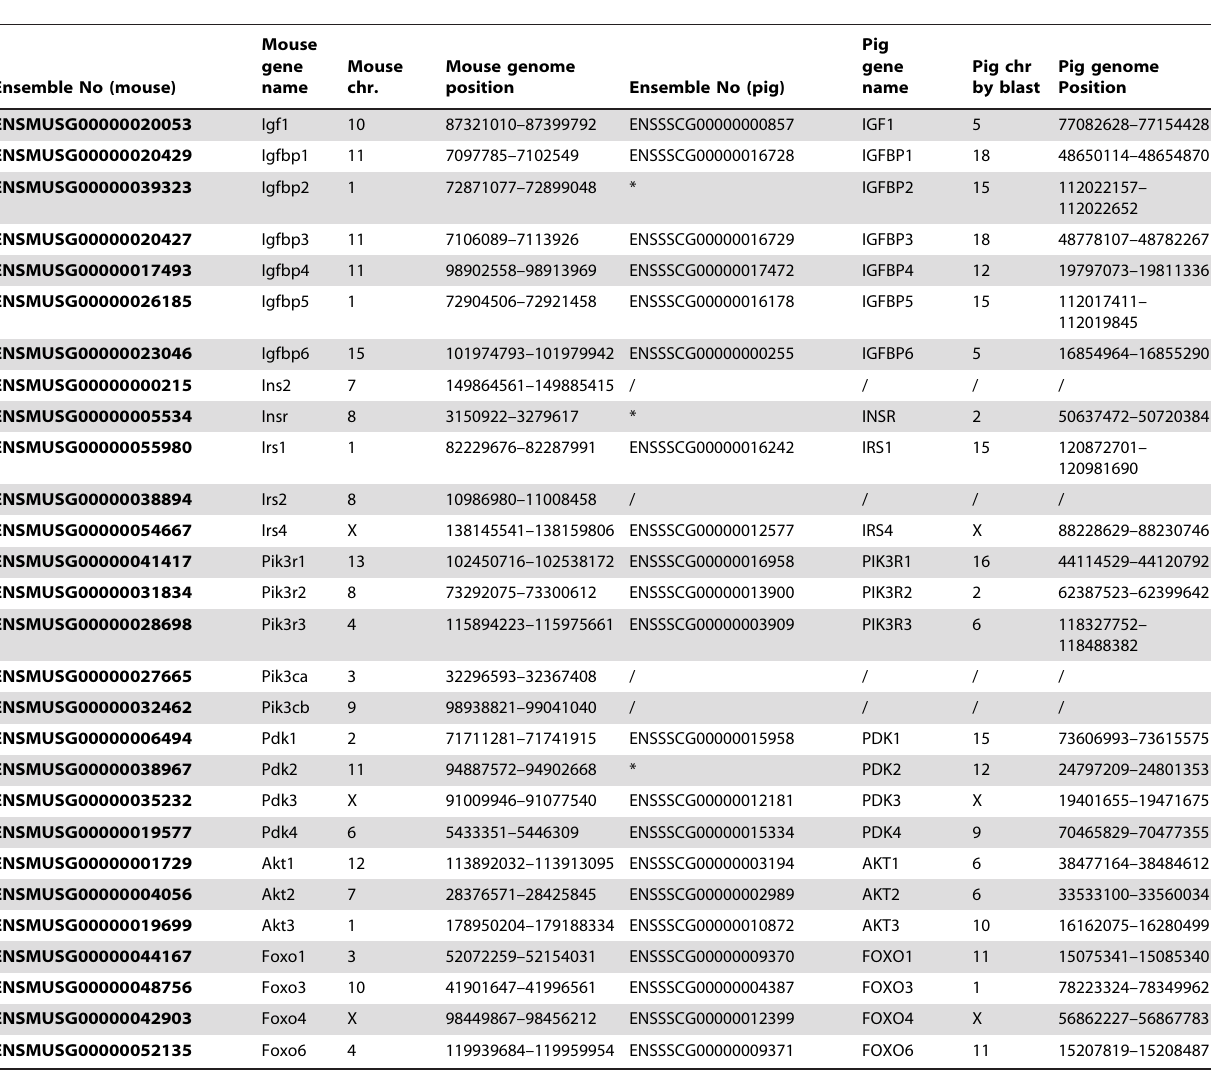
Table 1. The comparison of orthologs members between pig and murine IGF1/FoxO pathway.